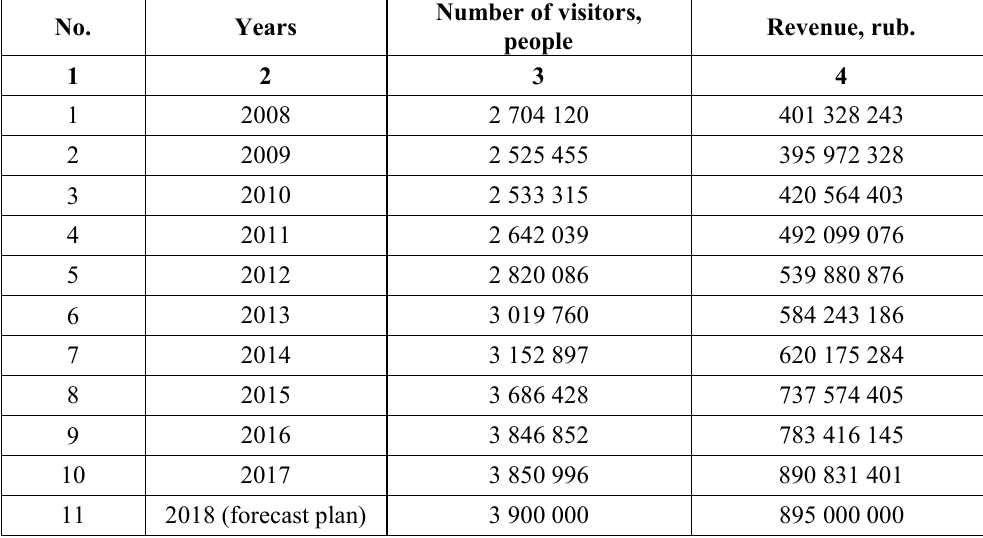
Table 1. Indicators of the Museum Activity of St. Isaac’s